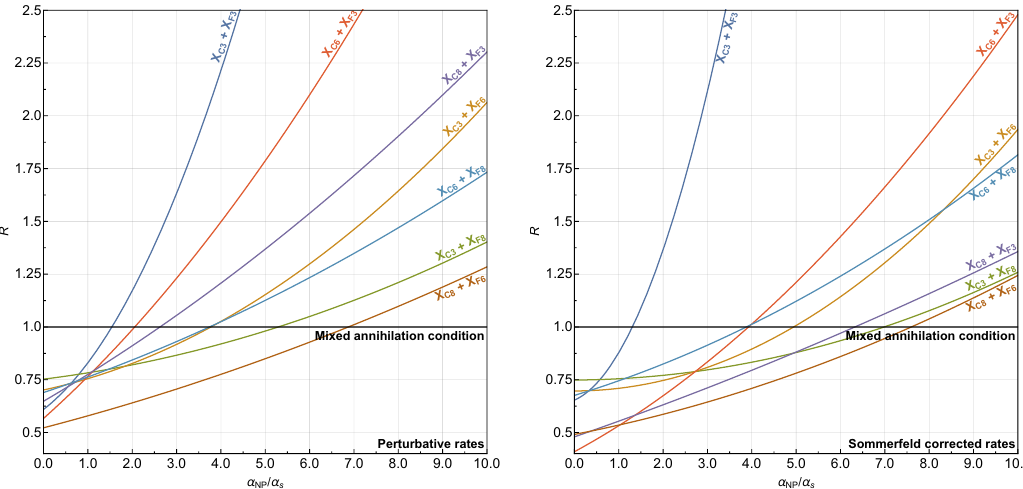
Figure 5 . Values of the ratio R of the e(cid:11)ective annihilation cross-section for two coannihilation partners over the maximum of the e(cid:11)ective rate with only either particle present, as de(cid:12)ned in equation (2.17), as a function of (cid:11) NP =(cid:11) s . We marginalize over the other relevant parameters g DM , m X and v as described in the main